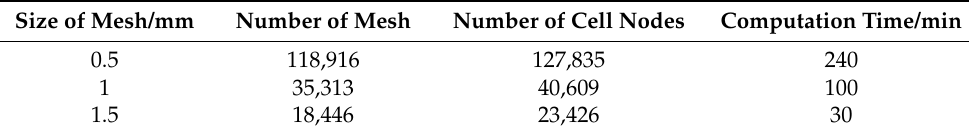
Table 5. Meso-mesh statistics of